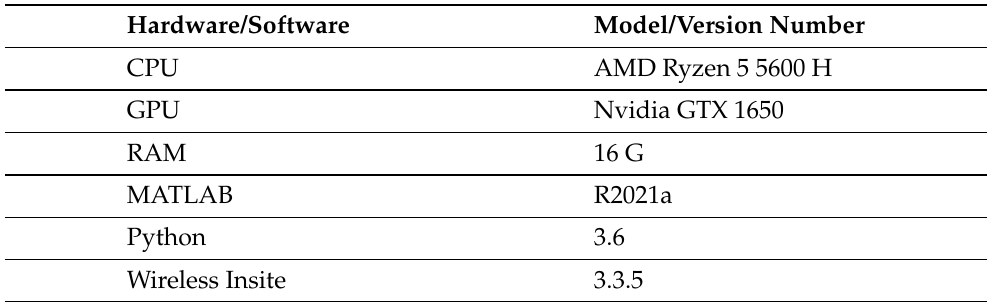
Table 4. Software and hardware used in simulation experiment and corresponding version